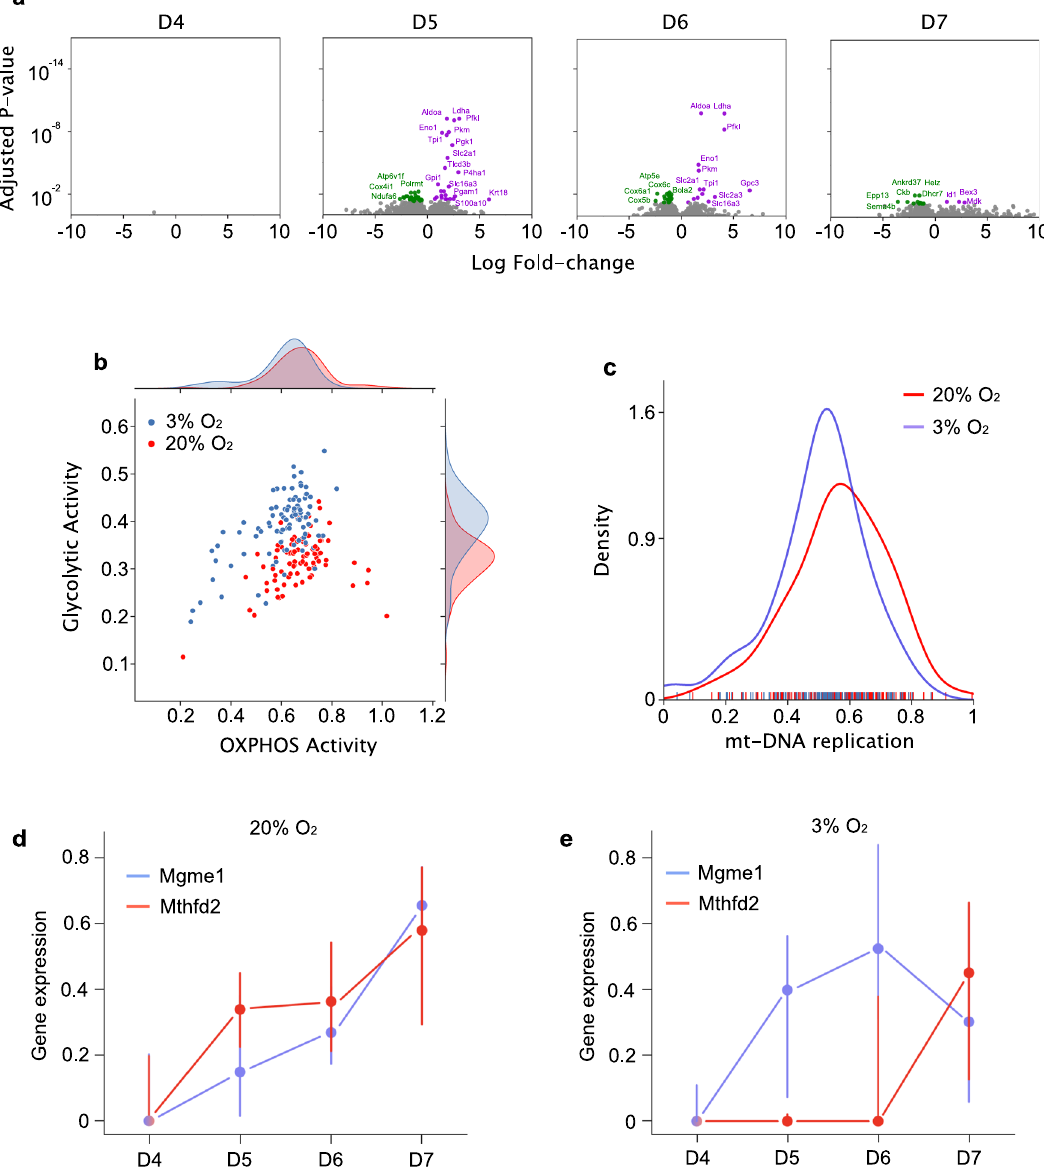
Fig. 4 Single-cell RNA sequencing in BVSC( + / − ) cells during WT cell differentiation in high and low oxygen concentrations. a Volcano plots showing the differentially expressed genes for each day between positive cells differentiating with the conventional (20% oxygen) and the modi fi ed (3% oxygen) protocol. Coloured dots represent signi fi cantly up-regulated (purple) and down-regulated (green) genes with multiple-testing corrected p -value < 0.05, as identi fi ed by Wilcoxon rank-sum tests (20% O2: D4: 47 cells, D5: 40 cells, D6: 45 cells, D7: 48 cells, n = 3; 3% O2: D4: 40 cells, D5: 48 cells, D6: 48 cells, D7: 48 cells, n = 3). b Scatter plots with marginal distributions showing the metabolism-related gene expressions in PGCLC at D5 and D6 (data combined together) when differentiated at low (blue) and high (red) oxygen concentration. Each dot represents a single cell. Its ( x , y ) coordinates are calculated by the number of genes expressed related to glycolytic ( y axis) and OXPHOS ( x axis) metabolism. Data consider the expression of 85 glycolytic genes and 96 OXPHOS genes (Supplementary Data 2). OXPHOS activity p -value = 4 × 10 − 3 , glycolytic activity p -value = 2 × 10 − 7 , Wilcoxon rank-sum tests were applied with signi fi cance threshold of 0.05 for DEG discovery, and Benjamini-Hochberg procedure was used to obtain multiple-testing corrected p -values (3% O 2 : 96 cells; 20% O 2 : 85 cells; n = 3). c Line plot showing the number of mtDNA-replication-related genes expressed per cell (mtDNA replication score, x axis) during PGCLC differentiation using the conventional protocol (red, 180 cells, n = 3) and modi fi ed protocol (blue, 184 cells, n = 3). The mtDNA replication score is calculated based on the expression of 18 genes (Supplementary Data 2), p -value = 0.0004, Wilcoxon rank-sum tests were applied with signi fi cance threshold of 0.05 for DEG discovery, and Benjamini-Hochberg procedure was used to obtain multiple-testing corrected p -values. d , e Mgme1 and Mthfd2 gene expressions during PGCLC differentiation at 20% ( d ) and 3% ( e ) oxygen concentration. Data represent the median of read counts ± SD. Wilcoxon rank-sum tests were applied with signi fi cance threshold of 0.05 for Differentially Expressed Gene (DEG) discovery and Benjamini- Hochberg procedure was used to obtain multiple-testing corrected p